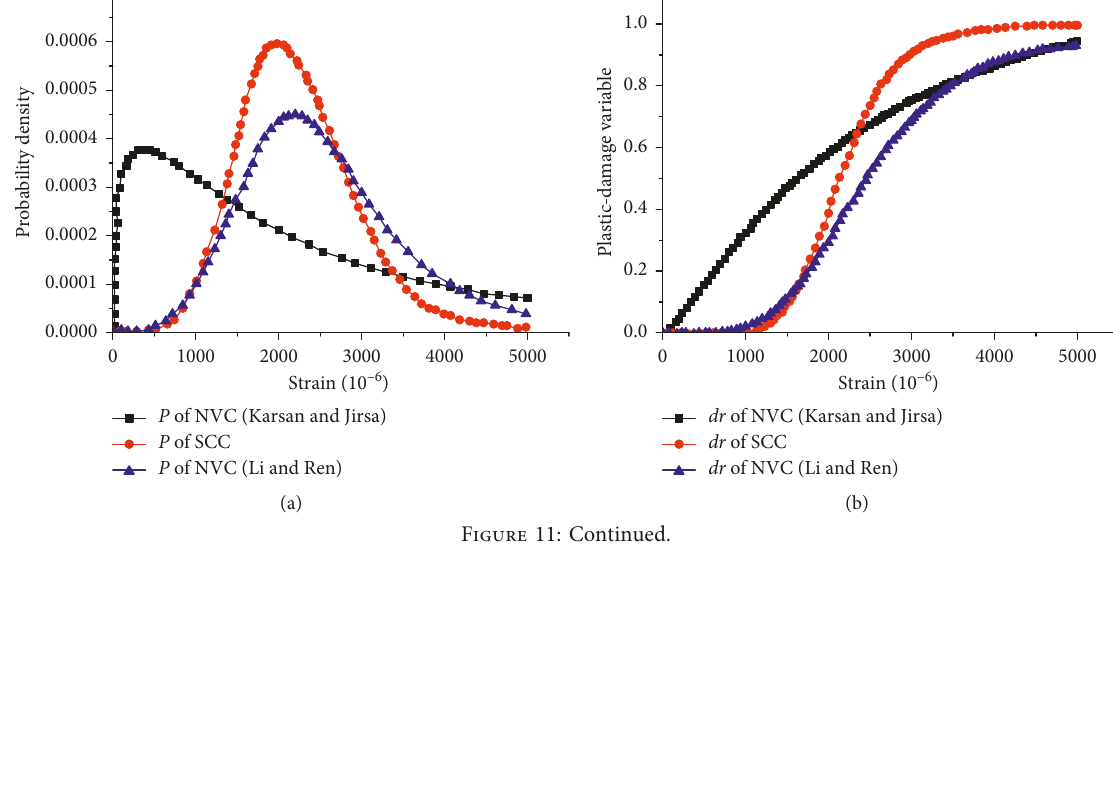
) and elastic modulus degradation of SCC under compression (elastic strain ε E ) in the elastic strain space ε E